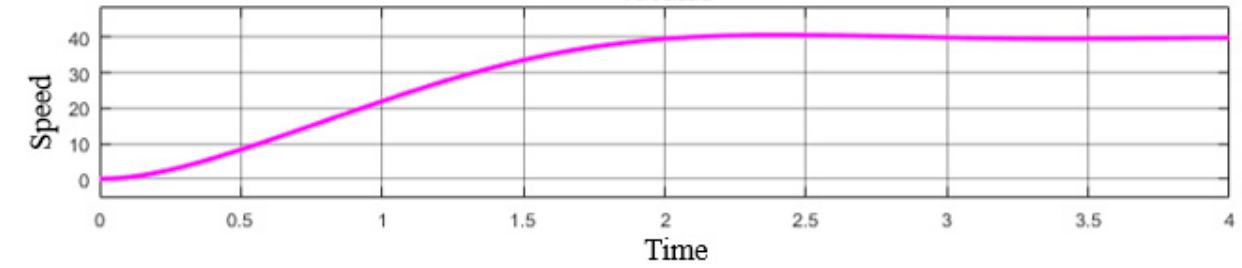
Figure 11. Best simulation result obtained with the presence of noise in the plant. Figure 12 illustrates the architecture of the fuzzy controller for the best simulation result obtained without considering noise applied in the control of the plant, and the surface is shown in Figure 13.